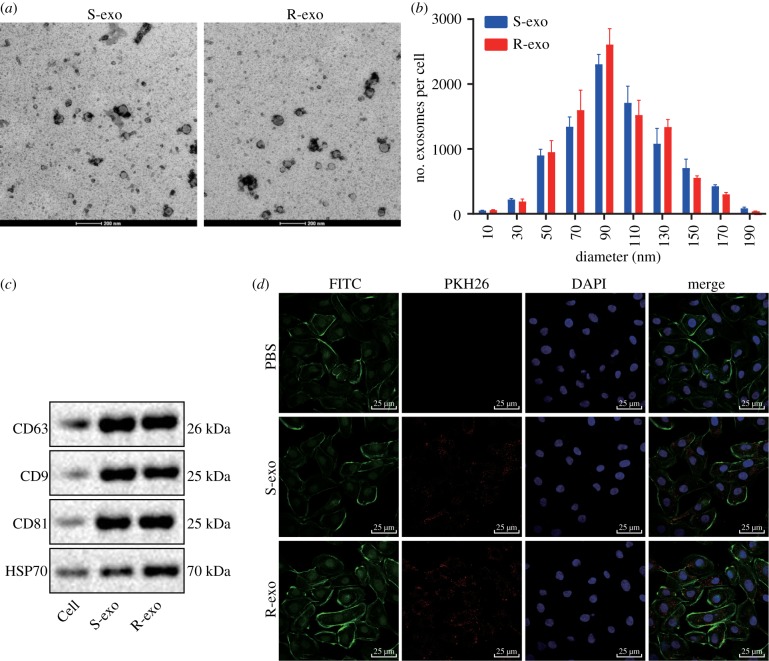
Exosomes derived from SKOV3 or SKOV3/DDP cells are internalized by OC cells. (a) Images of exosomes from SKOV3 cells (S-exo) and exosomes derived from SKOV3/DDP cells (R-exo) in 48 h culture supernatants under an electron microscope. Scale bar = 200 nm. (b) Size (diameter) and distribution of exosomes from SKOV3 cells (S-exo) and exosomes derived from SKOV3/DDP cells (R-exo) in culture supernatants for 48 h. (c) Western blot analysis of protein expression of exosome surface markers. (d) Confocal microscopic images of exosomes and OC cells (scale bar = 25 µm). Measurement data were expressed as mean ± standard deviation. Data between two groups were analysed by unpaired t-test. Cell experiment was repeated three times independently.